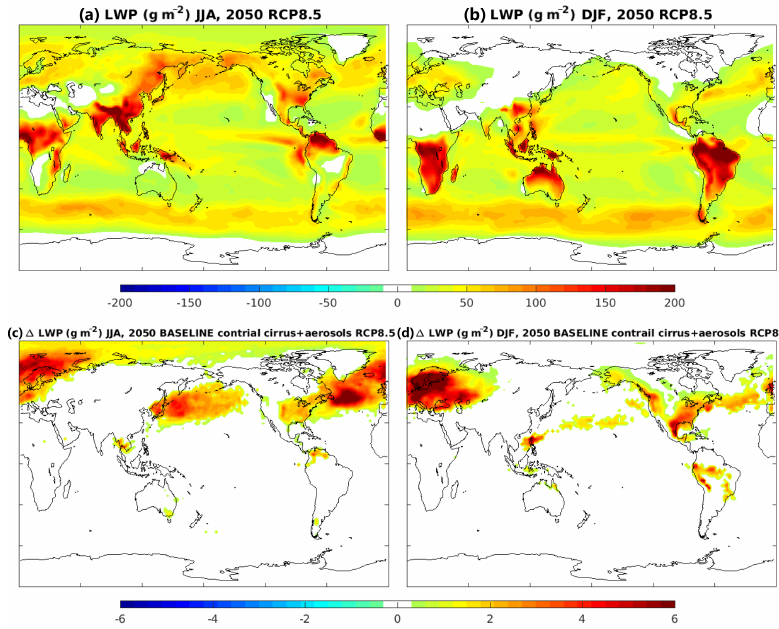
Figure 9. Seasonally averaged liquid water path in gm − 2 : (a) JJA background field of RCP8.5 2050 meteorology, (b) DJF background field of RCP8.5 2050 meteorology, (c) JJA difference (ensemble mean) due to contrail cirrus and aviation aerosols in 2050 and (d) DJF difference (ensemble mean) due to contrail cirrus and aviation aerosols in 2050. Only ensemble-mean perturbations above 2 standard deviations of the averaged control simulations are